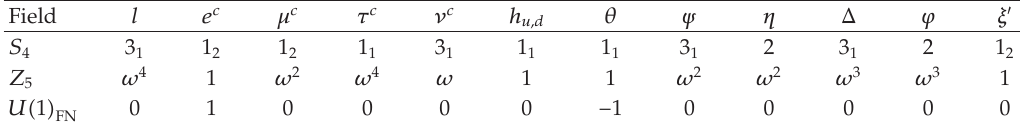
Table 1: Transformation properties of the lepton sector and all the flavons of the BMM model where ω (cid:7) e i 2 π/ 3